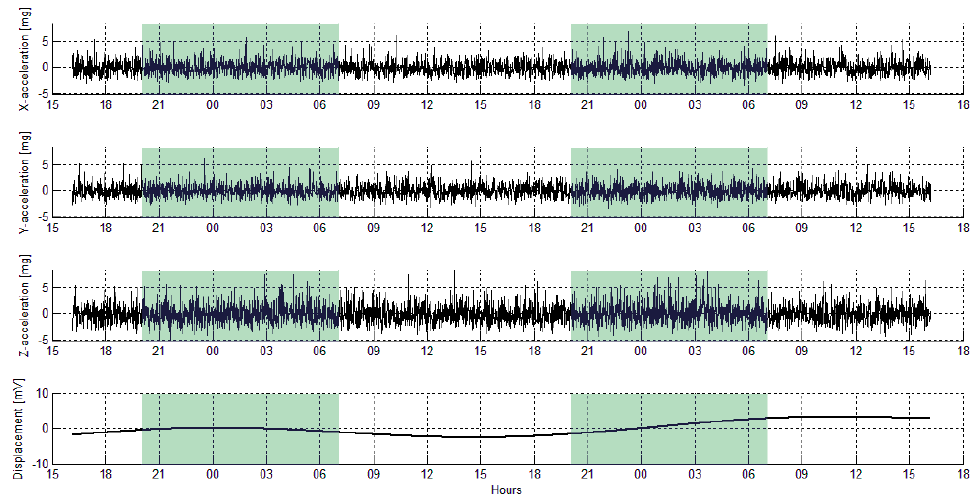
Figure 13. Results registered by node 2 (2-day interval).